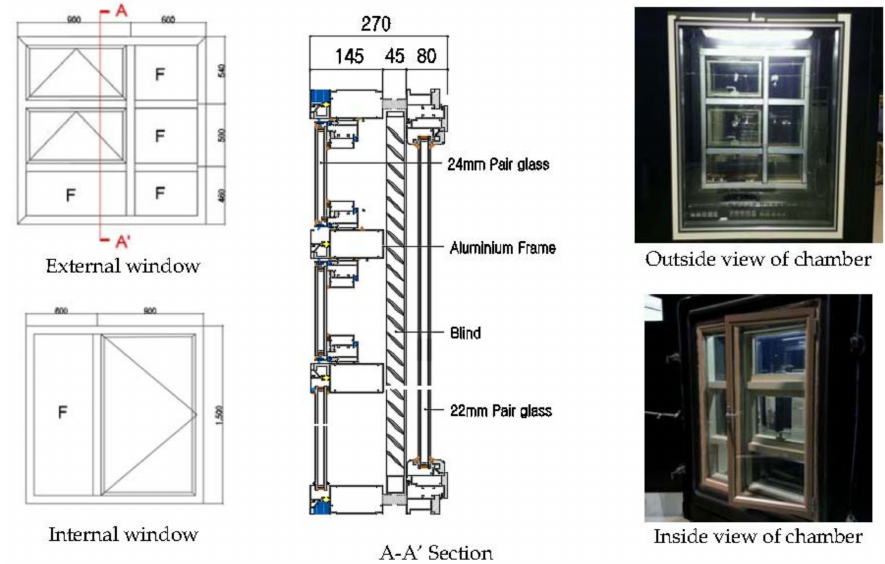
Figure 3. Slim-Type Double Skin Window System (SDSW) system for SHGC